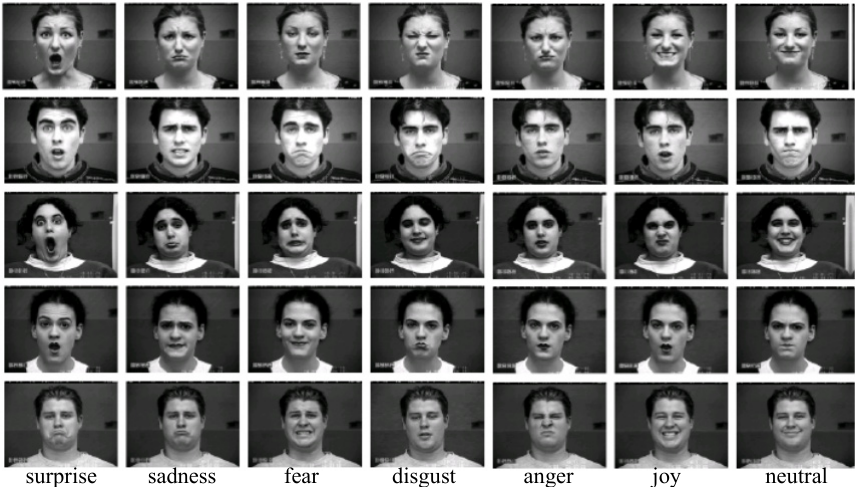
Figure 3. Examples of facial expression images from the Cohn-Kanade